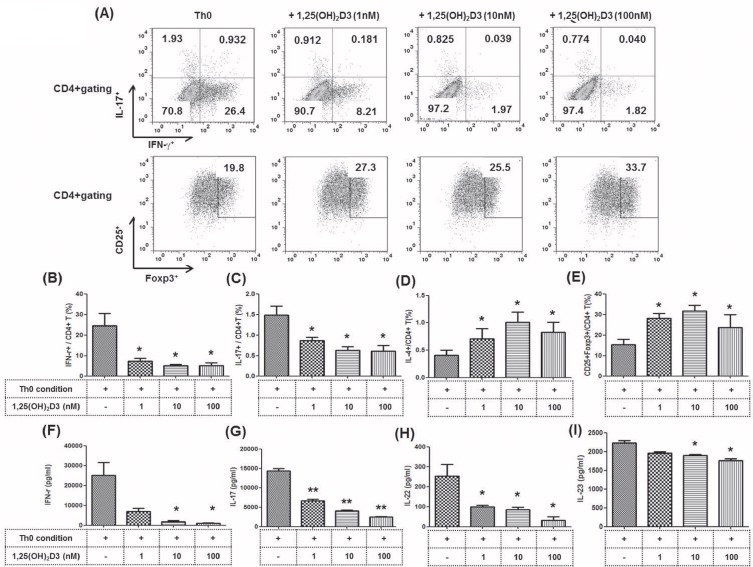
Effect of 1,25(OH)2D3 on CD4+ T cells isolated from the PBMCs of healthy donors and cultured under Th0-polarizing conditions.Human PBMCs (n = 3) were isolated from healthy subjects and pre-incubated with 1,25(OH)2D3 (1, 10, 100 nM) as indicated. They were then cultured under Th0-polarizing conditions (anti-CD3, 1 μg/mL and anti-CD28, 1 μg/mL) for 48 h. (A) PBMCs were stained with anti-CD4 PE-cy7, anti-CD25 APC, anti-IFN-γ FITC, anti-IL-17 PE, anti-IL-4 APC and anti-Foxp3 FITC. CD4+ T cells were gated for further analysis. Then, the percentage of (B) IFN-γ+/CD4+ T cells, (C) IL-17+/CD4+ T cells, (D) IL-4+/CD4+ T cells, and (E) CD25+FOXP3+/CD4+ T cells was measured by flow cytometry. The production of (F) IFN-γ, (G) IL-17, (H) IL-22 and (I) IL-23 by Th0-polarizing CD4+T cells and secretion into the culture supernatant by ELISA. Bars represent the mean 0± SD. * P <0.05, ** P <0.01 vs. Th0 condition. 1,25(OH)2D3, 1α,25 dihydroxy-vitamin D3; PBMC, peripheral blood mononuclear cells.